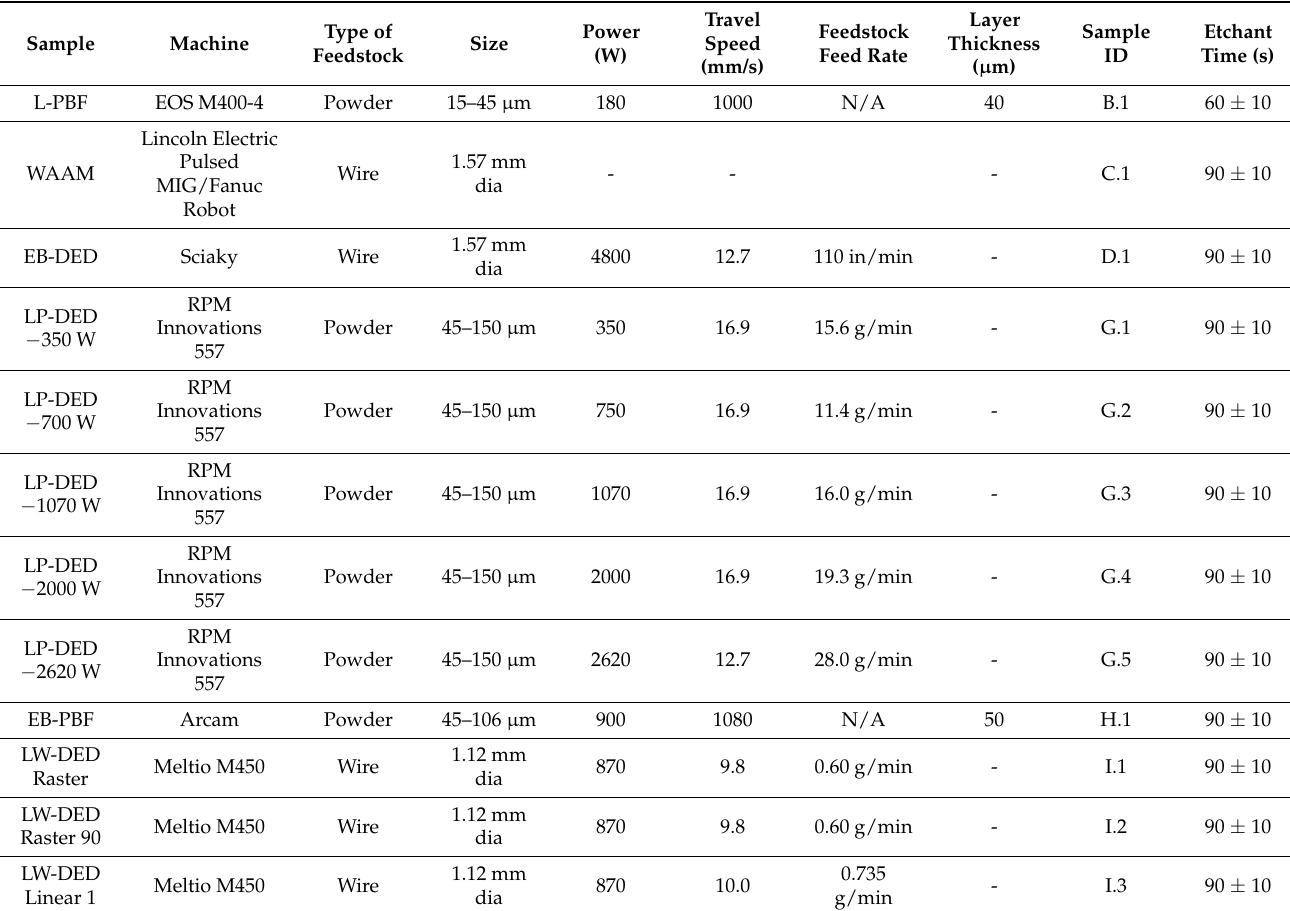
Table 1. As-built AM process parameters.